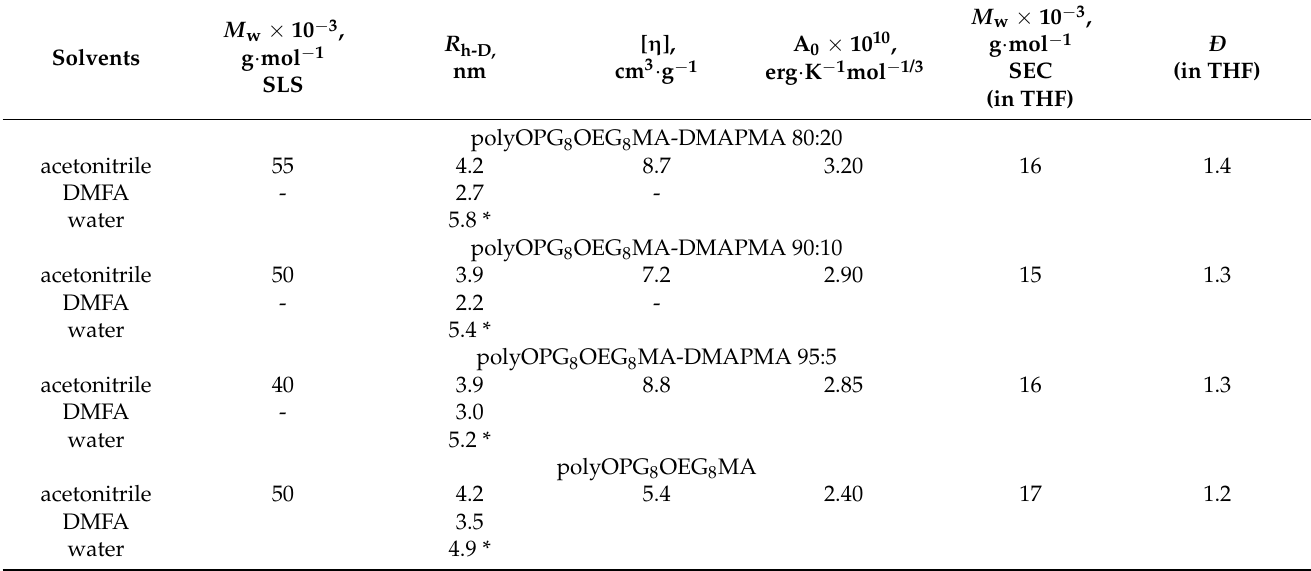
Table 1. Molar mass and hydrodynamic characteristics of polymer brushes.